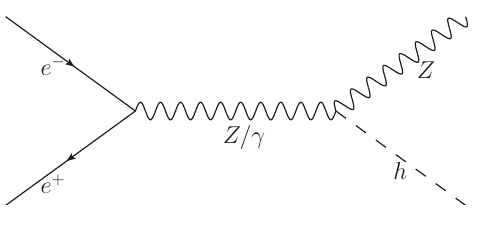
Figure 1 . Leading-order contribution to the Higgsstrahlung process, e + e